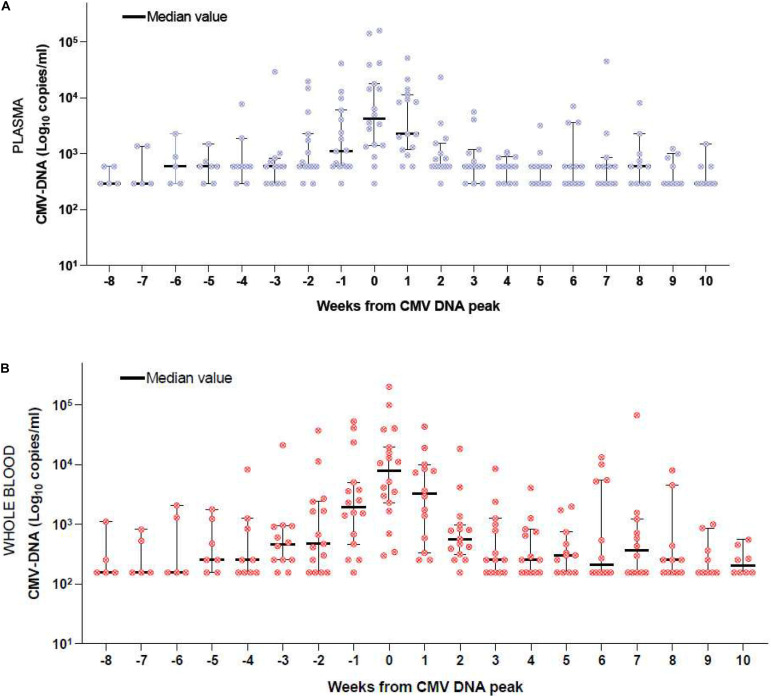
(A) CMV DNAemia monitored on PL of the 12 patients who received PET. Week 0 includes the maximum DNAemia. Negative weeks include the DNAemia before the peak and positive weeks include the DNAemia during PET. (B) CMV DNAemia monitored on WB of the 12 patients who received PET. Week 0 includes the maximum DNAemia. Negative weeks include the DNAemia before the peak and positive weeks include the DNAemia during PET.